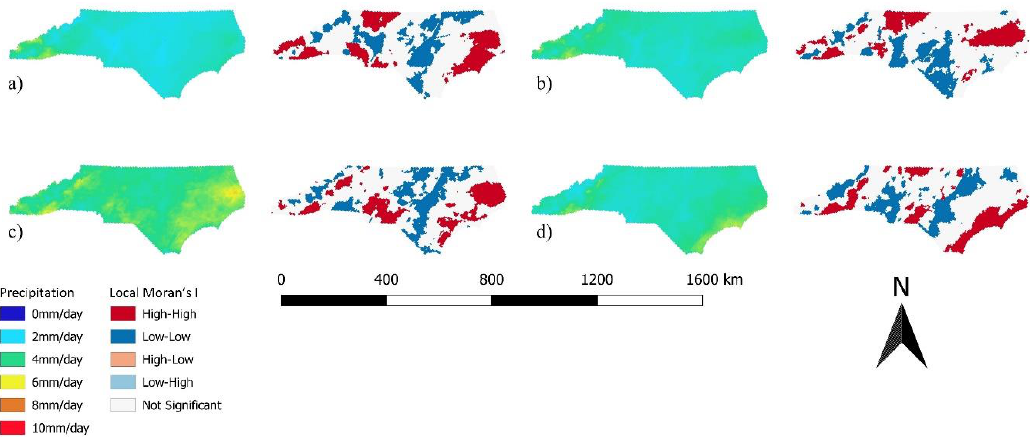
Figure 3. Daily average precipitation ( left ) and spatial clustering analysis of precipitation ( right ) for winter (DJF) ( a ), spring (MAM) ( b ), summer (JJA) ( c ), and fall (SON) ( d ) over the 2003–2018 study period. Local Moran’s I was calculated within each region individually.